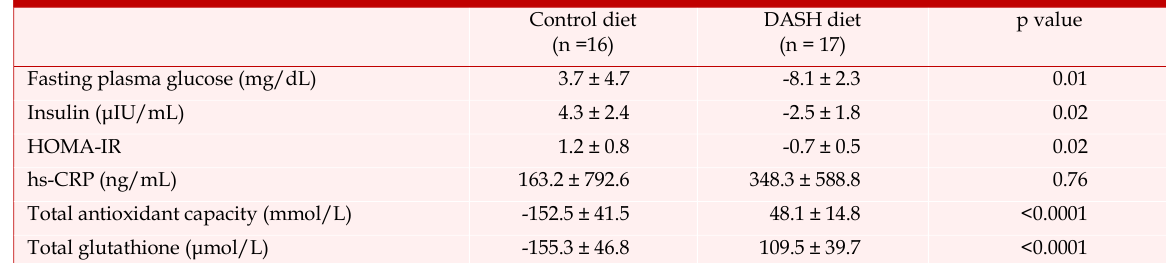
Effect of DASH diet on FPG, insulin, HOMA-IR, hs-CRP and stress